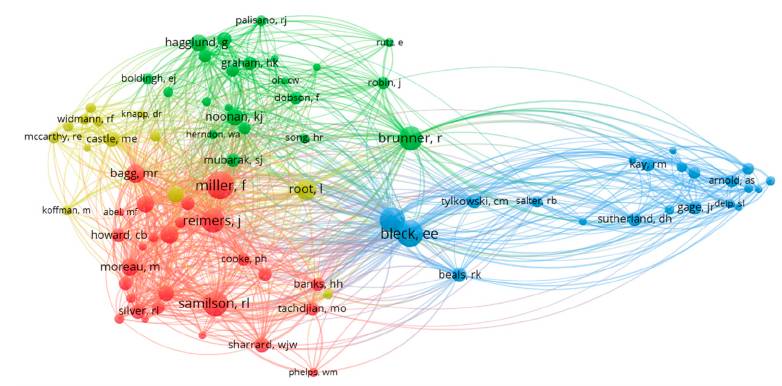
Figure 4. Co-citation by authors.